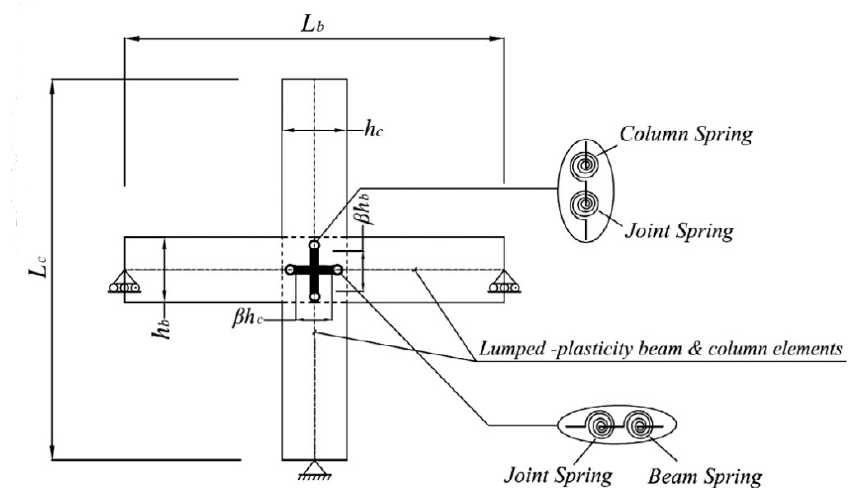
Figure 6. The proposed beam–column joint element with rigid offsets and details of rotational springs, based on literature [31].